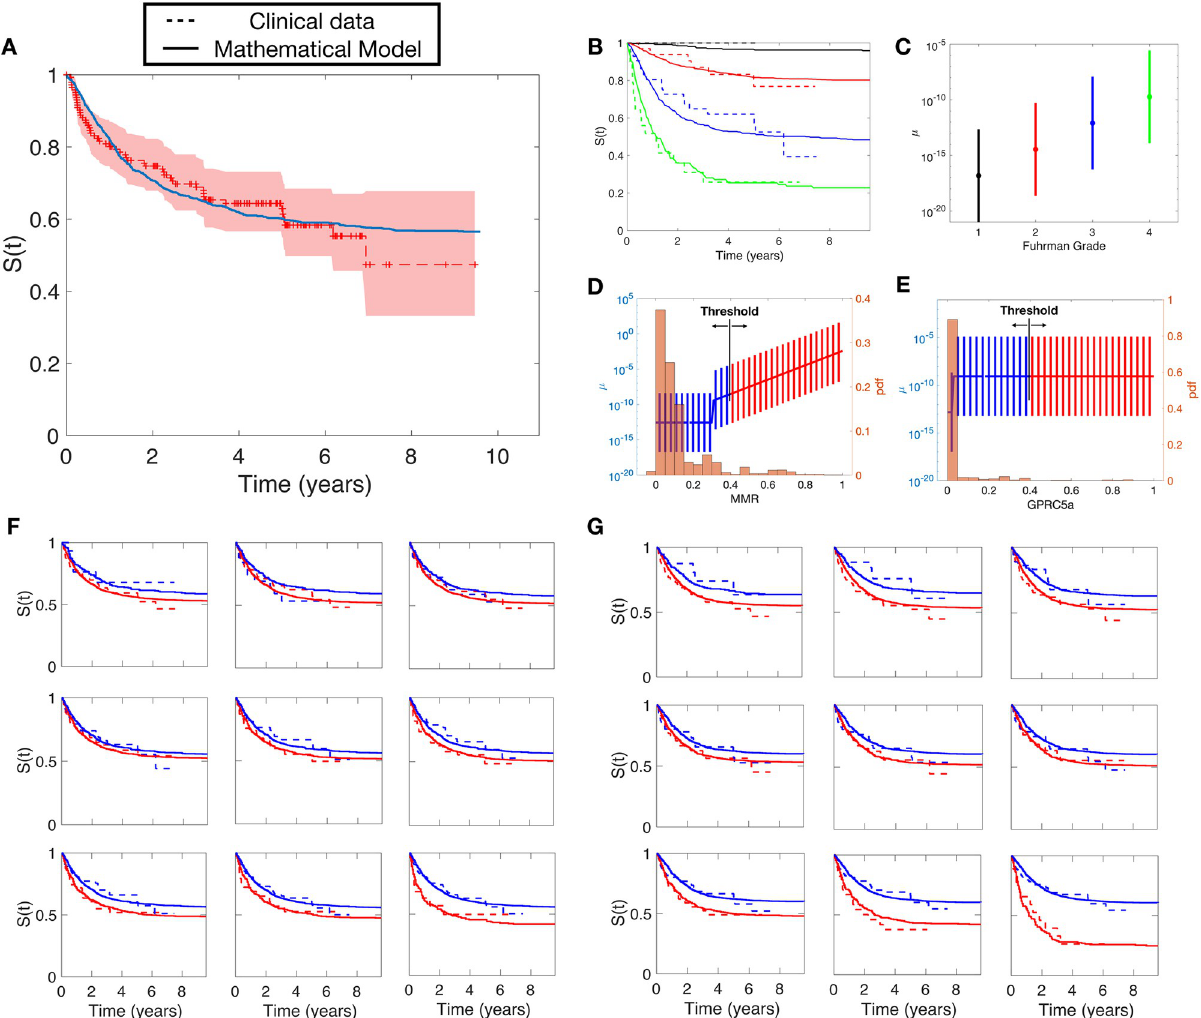
Fig 5. Results of the mathematical model applied to the clinical dataset. A) Goodness-of-fit between the model without covariates and the Kaplan- Meier estimator of the clinical data. B) Goodness-of-fit between the model with the effect of FG in μ and the data separated by FG groups. Individual μ i distributions according to values of C) Fu¨hrman Grade, D) MMR, E) GPRC5a F) Goodness-of-fit for the model with a constant and linear effect in μ for the covariate MMR. The different subfigures are the fits obtained for different thresholds. Dashed lines correspond to the clinical data and solid lines correspond to simulations. Blue lines are the results for group 1 ( MMR i < threshold ) and red lines for group 2 ( MMR i � threshold ). G) Goodness-of-fit of the fit between the model with a group effect in μ for the covariate GPRC5a.